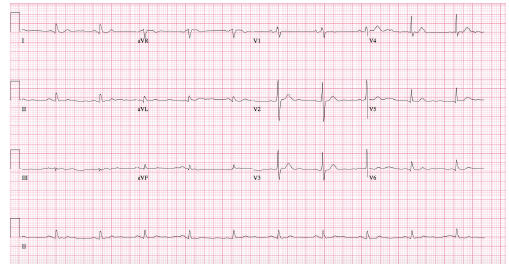
Figure 4: 12-lead EKG showing normal sinus rhythm, with resolu- tion of the previously seen ST segment elevations in the inferior wall leads (II, III, and